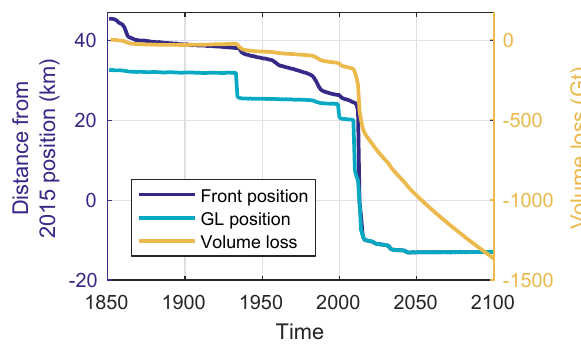
Figure 7. Simulated front and grounding line (GL) positions with accumulated volume loss for the step forcing (Table